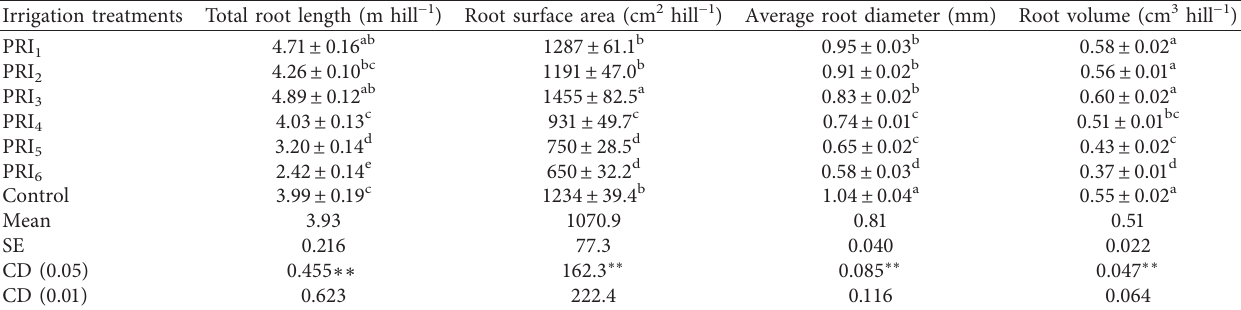
Table 3: Root traits changes of PMK ( R ) 3 rice by split root experiment.